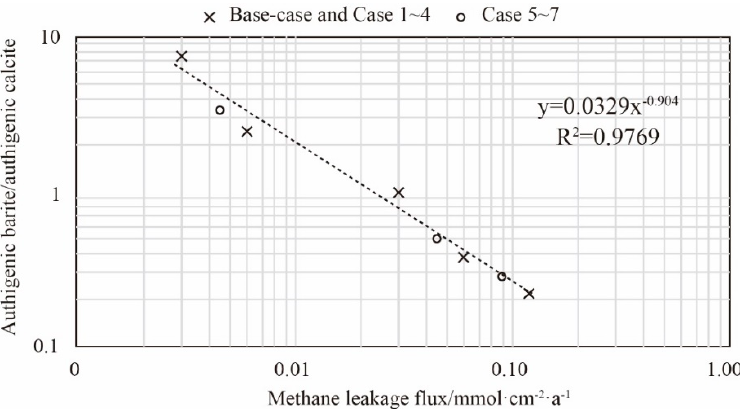
Figure 8. Diagram of methane leakage flux vs. the changing vol. fraction of barite to calcite (Cases 1–4 are used for regression analysis, and Case 5–7 for verification).